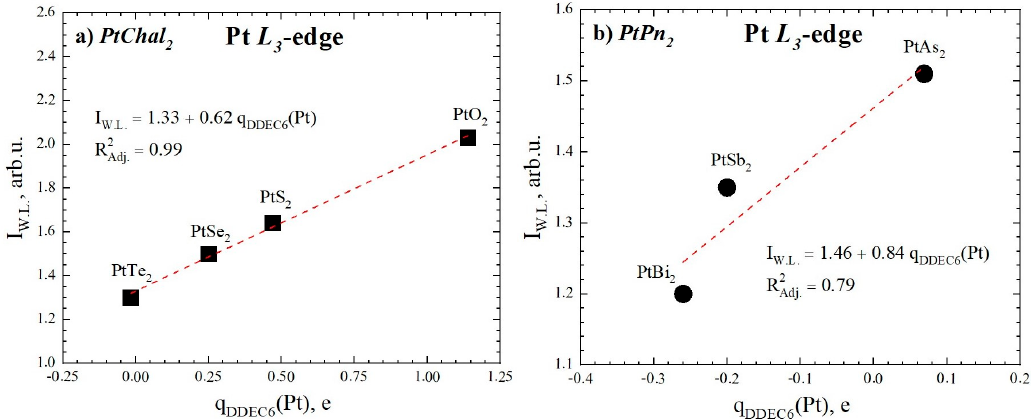
Figure 5. The correlation between intensity of white line (I W.L. ) of Pt L 3 spectra and Pt DDEC6 charge. ( a ) PtChal 2 and ( b ) PtPn 2 groups.